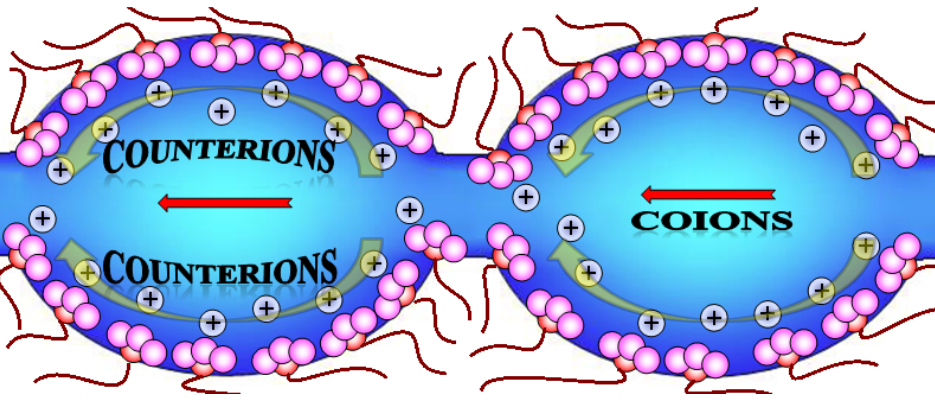
Figure 7. Scheme of ion transfer in the membrane pores and channel system.